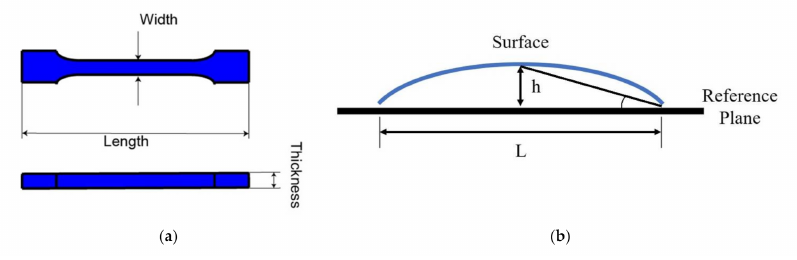
Figure 4. ( a ) Shrinkage measurement position and ( b ) warpage measurement